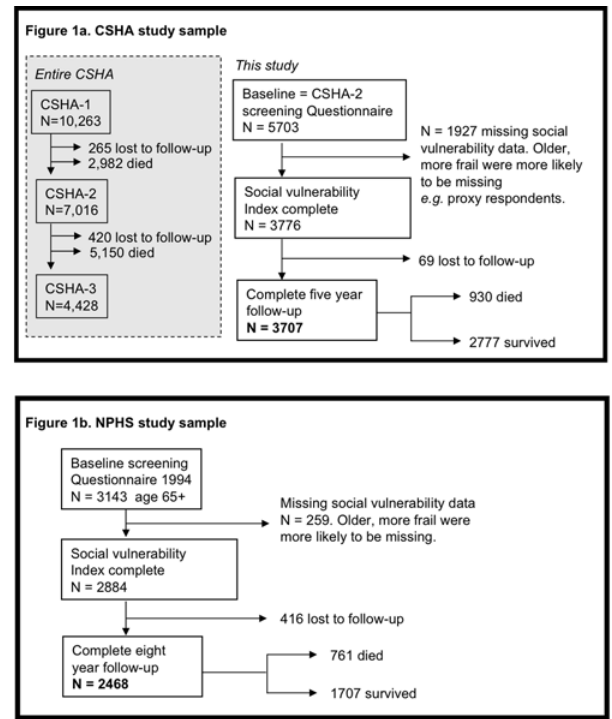
Figure 1. Composition of the Canadian Study of Health and Aging sample (Panel a) and the National Population Health Survey (Panel b).